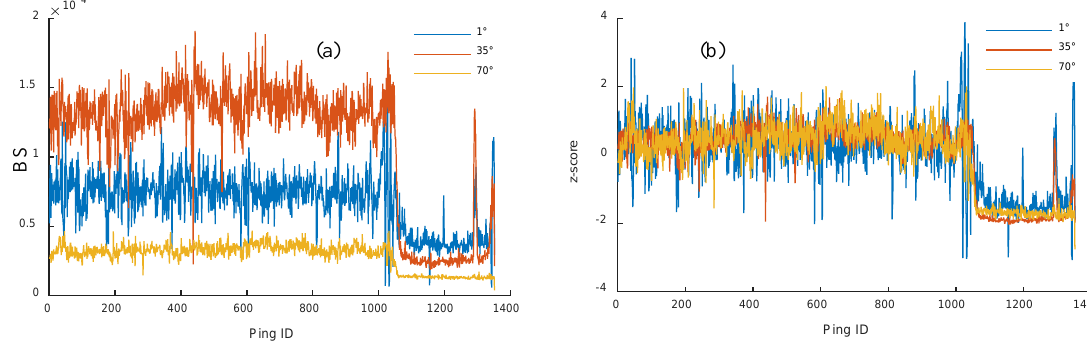
Figure 7. ( a ) Along-track BS sequences of different incident angles; and ( b ) their z-score sequences.